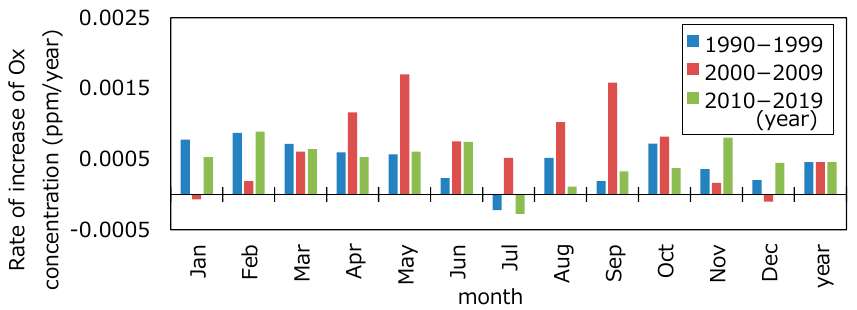
Figure 5. Rate of increase in monthly average Ox concentrations for each month. Ox concentrations: same as Figure 4. Rate of increase: slope of linear regression line for monthly averages for each decade.